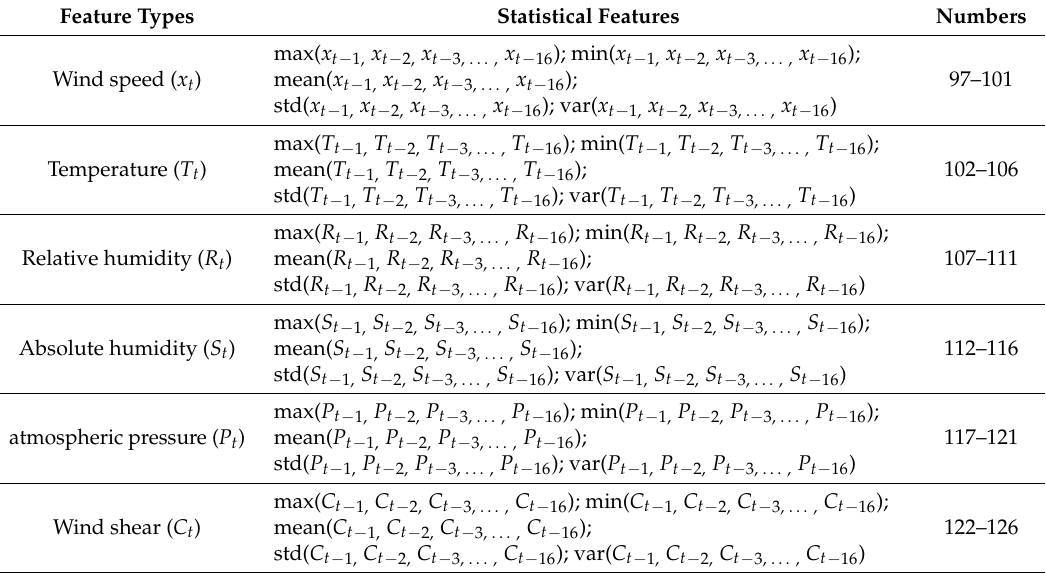
Table 2. The original statistical feature set and the features’ serial